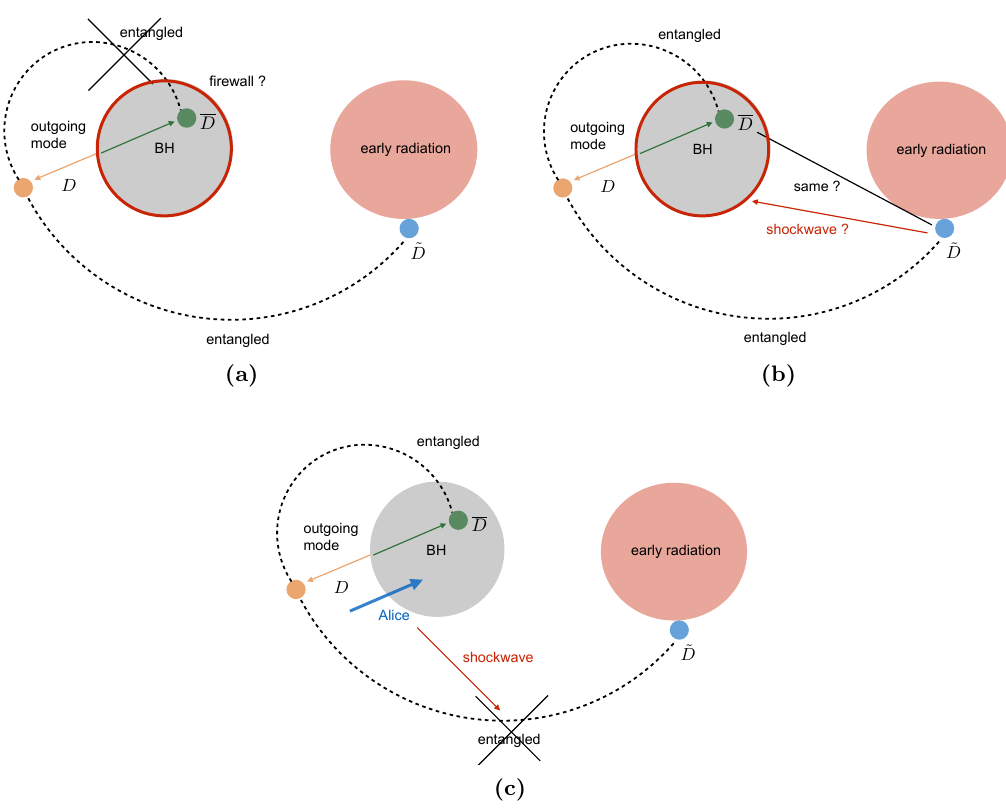
Figure 12 . Schematic pictures of (a) the AMPS argument, (b) some previous proposals and (c) our